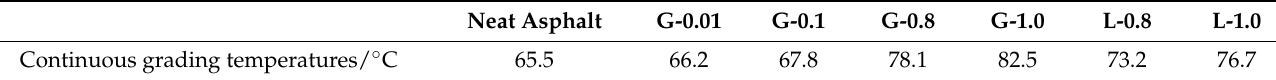
Figure 3. The phase angles of asphalts and mastics. Table 4. Continuous grading high temperature. Table 4. Continuous grading high temperature.